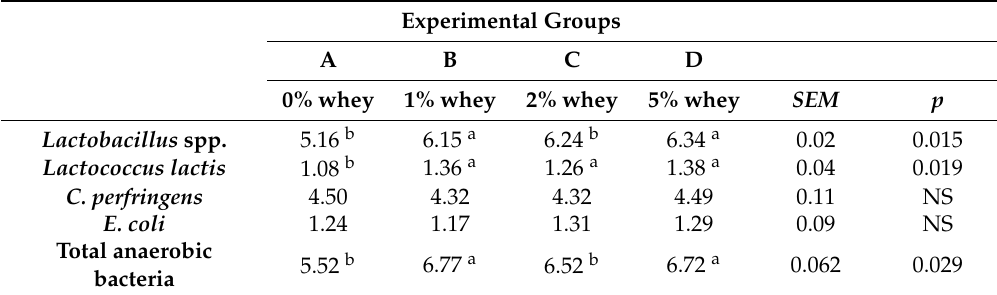
Table 5. E ff ect of whey in various concentrations in poultry diets on cecal bacterial counts (log cfu /